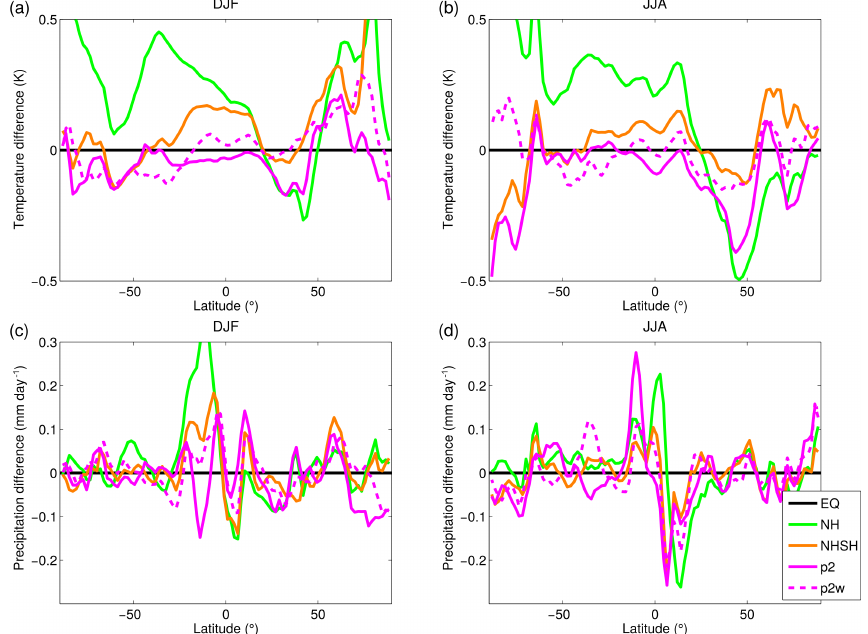
Figure 10. The zonal mean anomalies for the temperature in (a) December–January–February and (b) June–July–August and for precipitation in (c) December–January–February (d) June–July–August compared to scenario